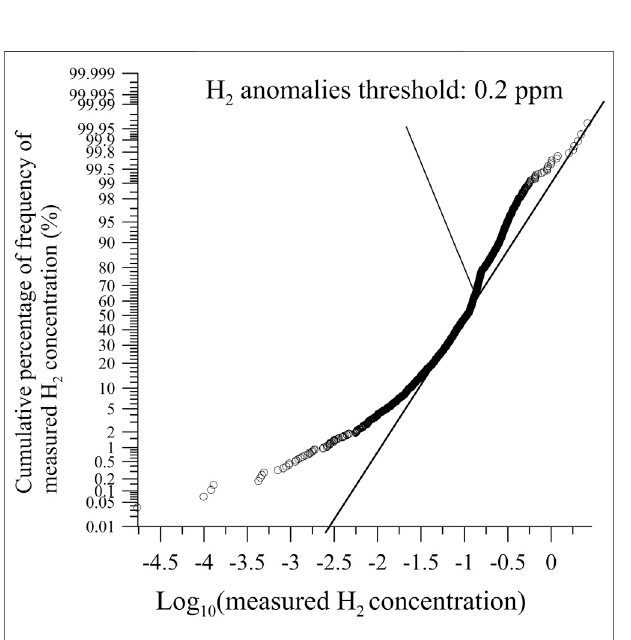
FIGURE 5 | Q – Q plot of H 2 concentration.